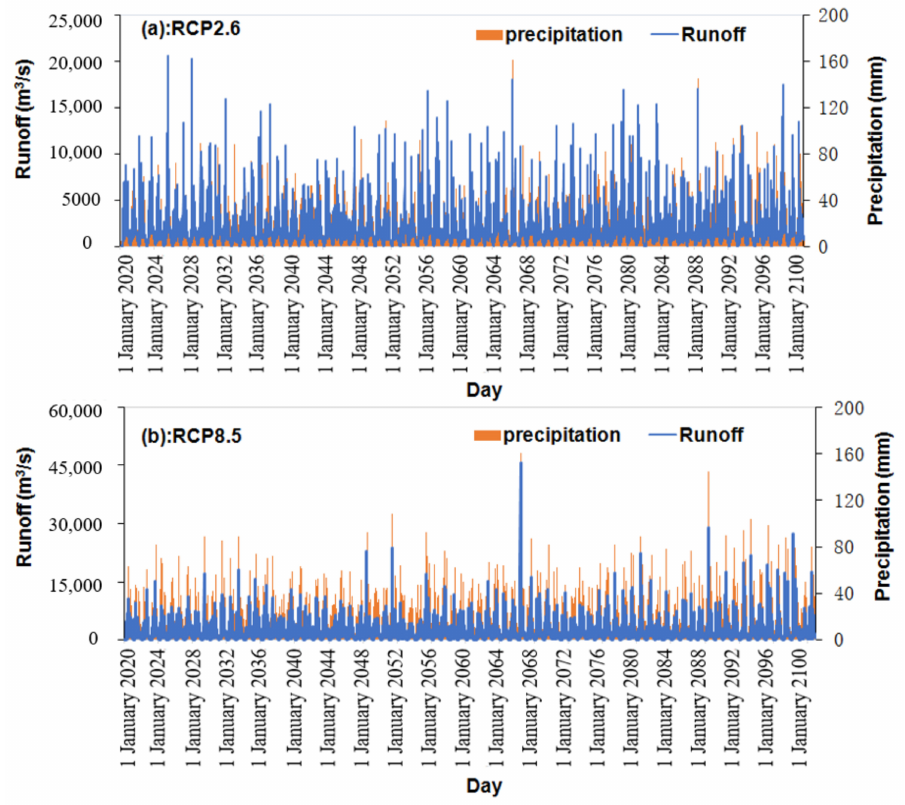
Figure 14. Runoff and precipitation prediction under the greenhouse gas emission scenarios of RCP2.6 ( a ) and RCP8.5 ( b